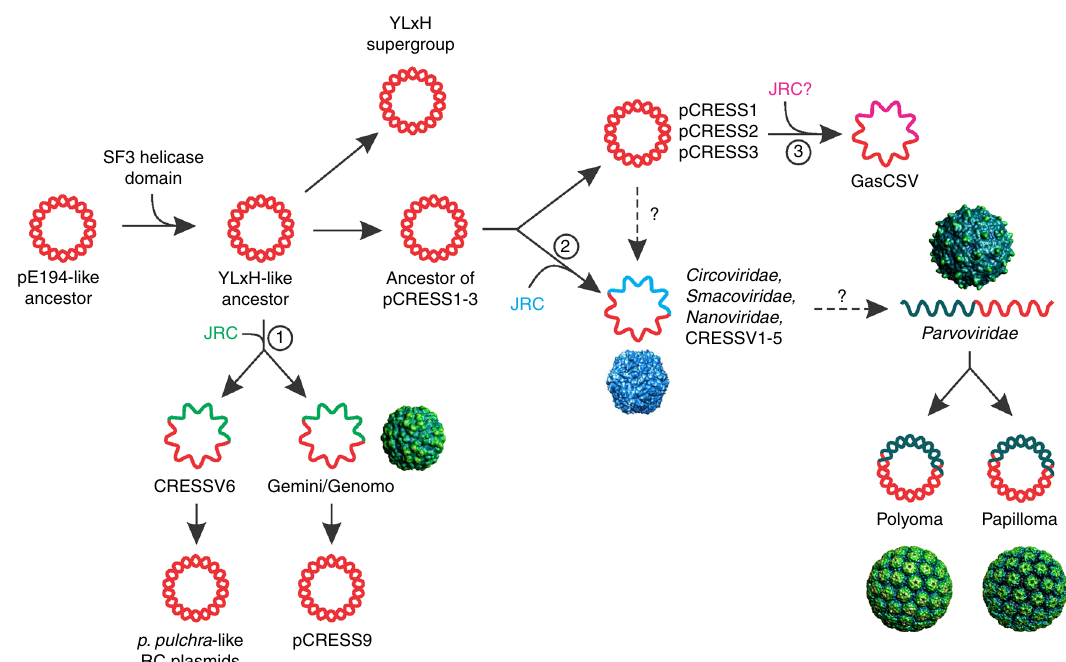
Fig. 6 A proposed evolutionary scenario for the origin of CRESS-DNA viruses from bacterial plasmids. The three hypothetical events of CRESS-DNA virus emergence are indicated with numbered circles. JRC, jelly-roll capsid protein-encoding genes. Non-orthologous JRC genes are indicated with different